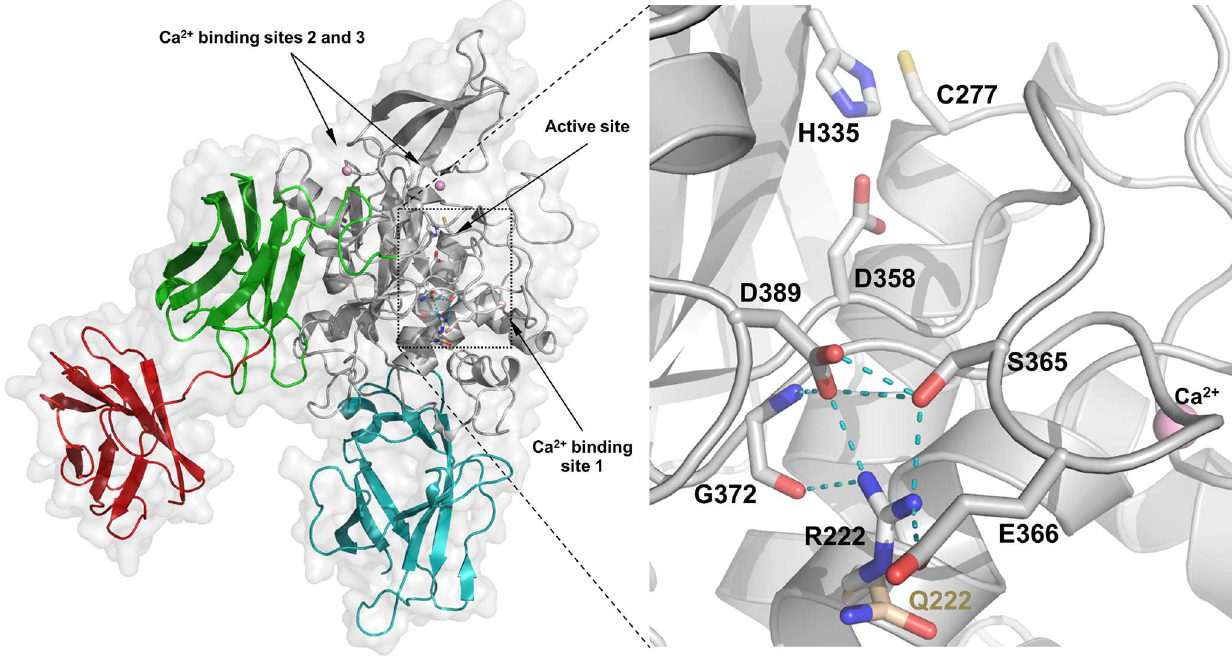
Fig 4. Structural interpretation of the effect of the p.Arg222Gln variation on enzyme activity. We analyzedthe interactions of R222 in a homology model of TGM2 containingthree bound calciumions (pink spheres), which supposedly corresponds to the active form (cyan: N- terminal, grey: catalytic, green and red: first and second beta barrel domainsrespectively). The squaredarea in the left panel is magnifiedon the right. R222 is locatedin the middleof the solvent accessiblesurface of the α -helixleadingup to calcium bindingsite S1 (226–233).R222 is at the core of an H-bondnetwork (light blue dashedlines) that serves to bundleneighboring structural elementsof TGM2 together. Upon bindingof calcium to site 1, H-bondsbetweenE232, N229 and backboneatoms of Y369, and H-bondsof R222 to S365, E366, G372, and D389 cooperatively tether the flexible loop, P359-G372. The changingconformation of this loop leads to reorganization of another non-covalent interaction network near calcium bindingsite 2, includinga directly calcium bindingresidue, N306, for metal binding,and to honingof the charge relay duad, E305-E363 that has recently identifiedimportance for catalysis [26]. The Q222 variant (wheat) fails to establishthe critical H-bonds with S365, E366, and E389, thus the calciumbindingof both sites are impairedand the chargerelay system is also negatively affected. The same loop, most probably, also contributes residuesto the amine substrate bindingsurface and controls access to the active site (C277/H335/ D358), likely explainingthat the Q222 enzyme has conservedtransamidase activity for a small molecularamine, but compromised cross-linking activity towards a protein amine donor and lost isopeptidase activity for a protein-peptide conjugate.